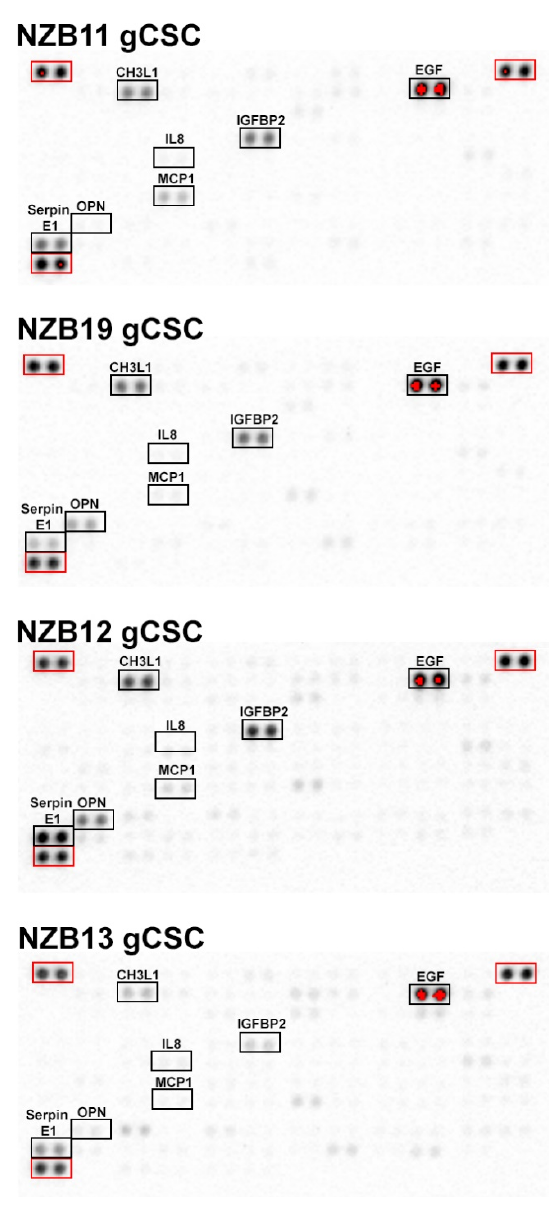
Figure 3. Proteome Profiler Human XL cytokine arrays of NZB glioblastoma conditioned medium. NZB11, NZB19, NZB12 and NZB13 glioblastoma cell 48 h conditioned medium. Arrays were imaged equivalently by chemiluminescence. Shown is each array 10 s before reference spot saturation (red).